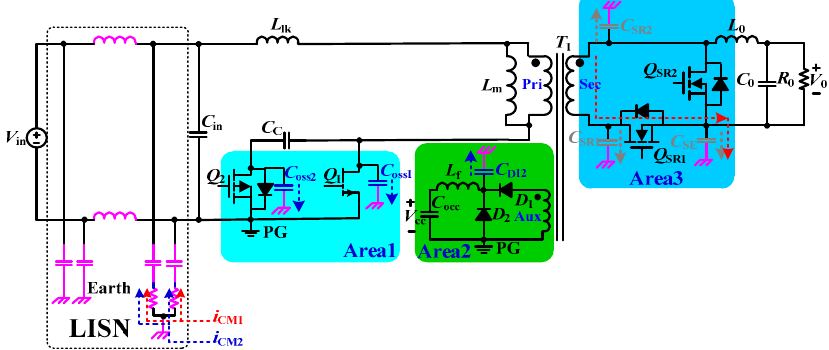
Figure 14. CM noise paths of GaN-based active clamp forward (ACF) converter.